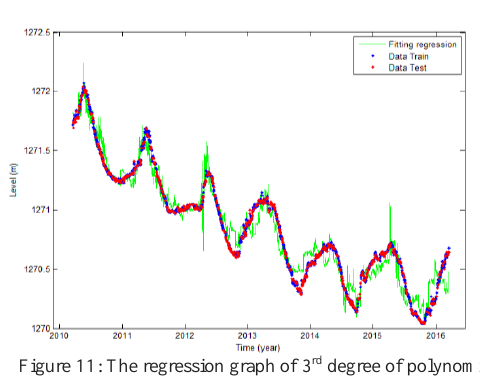
Figure 10: The regression graph of 2 nd degree of polynomial